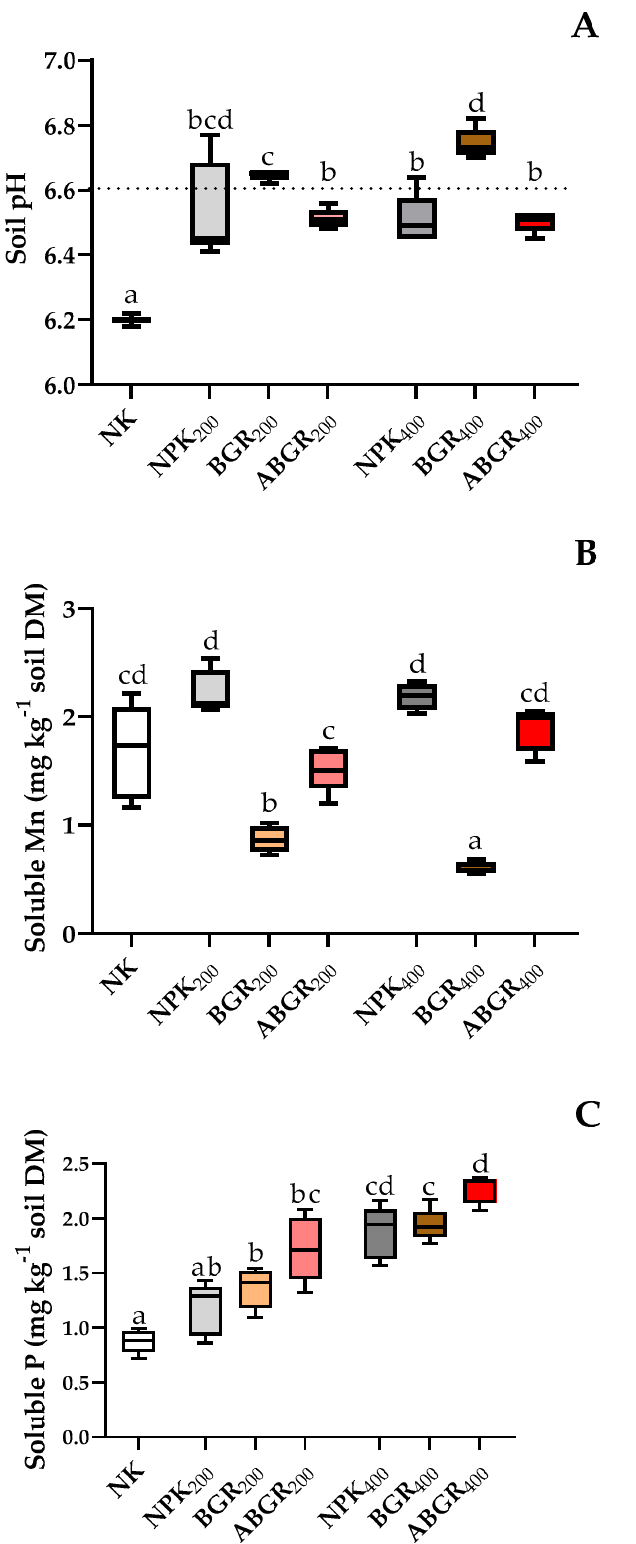
Figure 1. ( A ) Soil pH (CaCl 2 ) at the end of the experiment. The dashed line corresponds to the initial soil pH. ( B ) Soluble Mn. ( C ) Soluble P. For treatment abbreviations, see Table 1. Different letters above the box plots indicate significant differences ( p ≤ 0.05) between treatments.